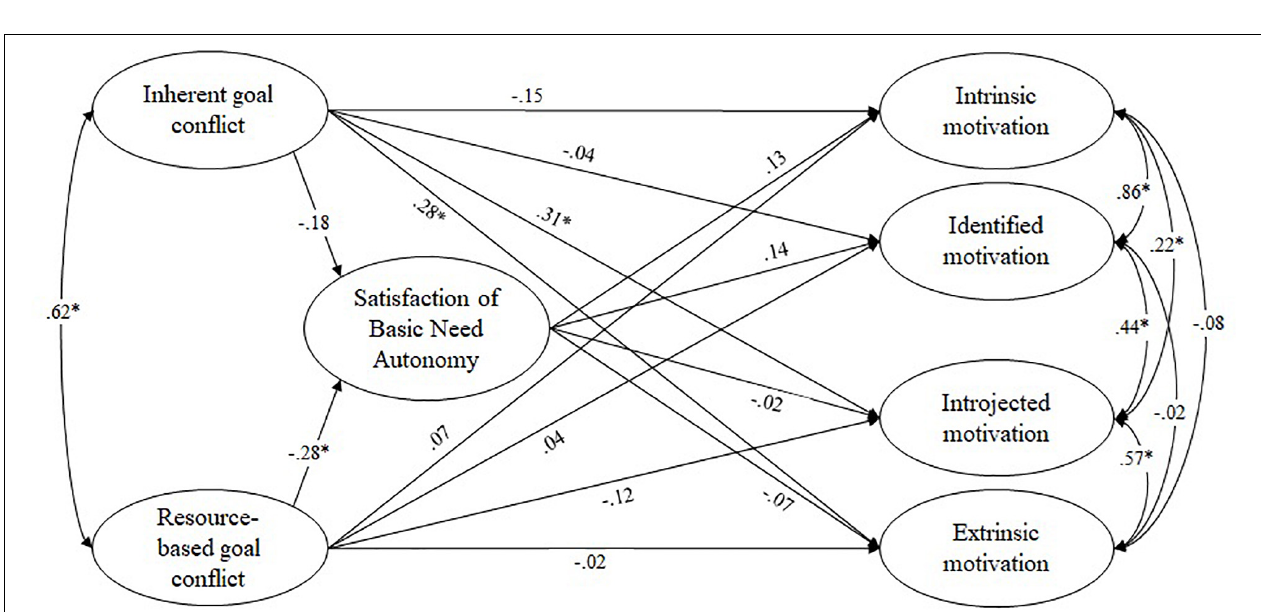
FIGURE 4 | Path coefficients from structural equation modeling: frequency of experiencing goal conflict affecting teaching motivation via the satisfaction of the basic need for autonomy. Figure depicts standardized beta weights, correlations between latent variables were specified as residual error correlations; * p < 0.05.